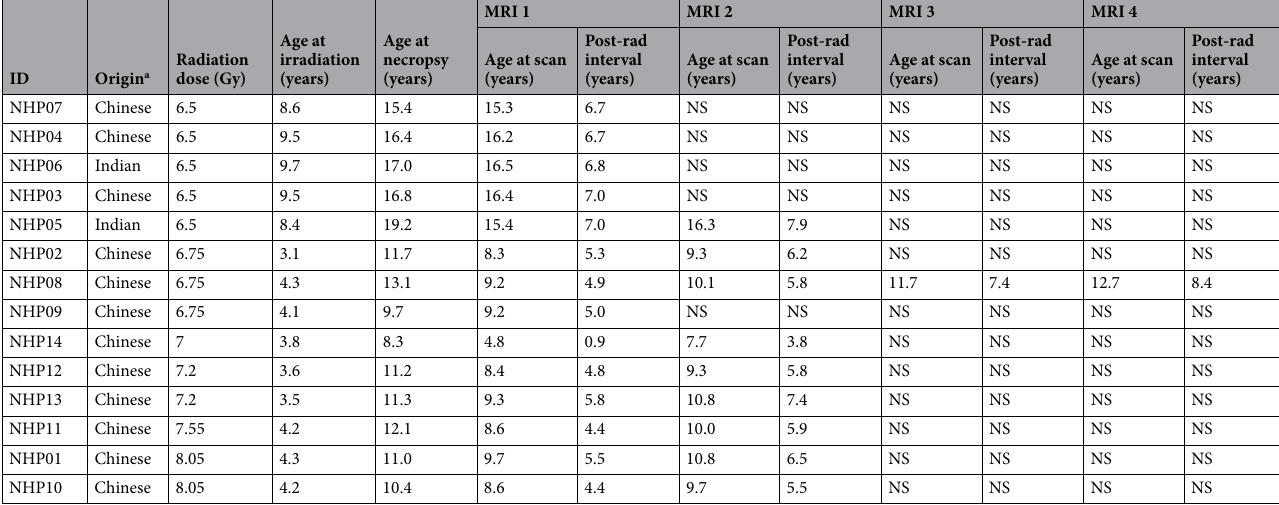
Table 2. Animal demographics and MRI schedule. a Origin refers to the genetic background of the animal. NS not